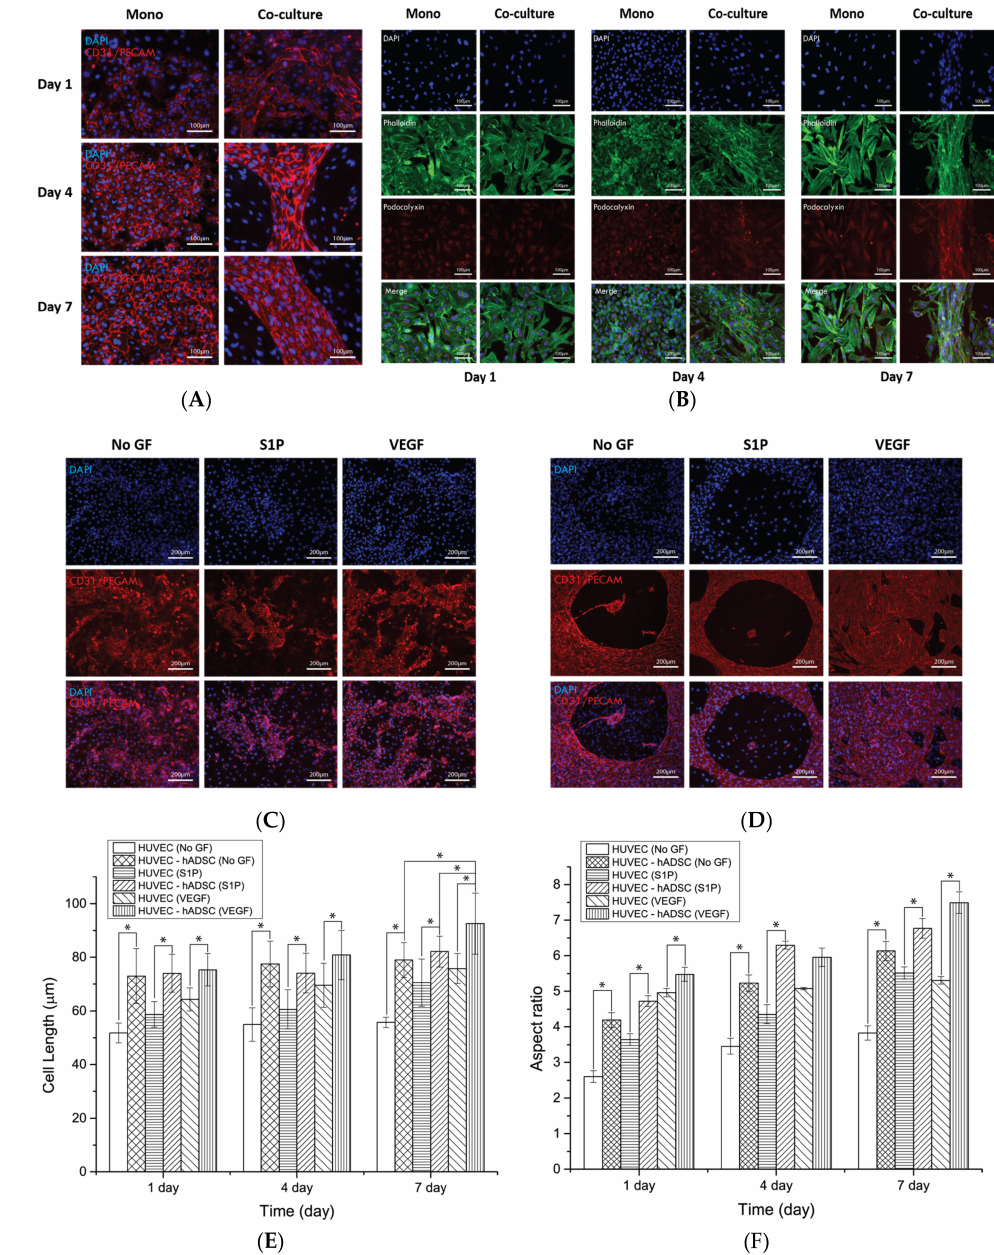
Figure 4. Blood vessel formation by HUVECs during mono- and co-culture growth in 24-well plates as assessed by immunofluorescence staining of blood vessel phenotypic markers. ( A , B ) Immunofluorescence imaging of the expression of endothelial cell markers: ( A ) intercellular junction protein CD31/PECAM and ( B ) podocalyxin at one, four, and seven days; ( C , D ) Representative immunofluorescent images of CD31/PECAM of HUVECs cultured in ( C ) monoculture system and ( D ) co-culture system to observe HUVEC behavior during different medium conditions in 24-well plates after seven days of culture; ( E ) Extent of HUVEC growth in 24-well plates under several culture conditions; ( F ) Aspect ratio of HUVECs in the 24-well plate under several culture conditions. One-way ANOVA, Tukey’s post hoc test; * compared to each group; * p <